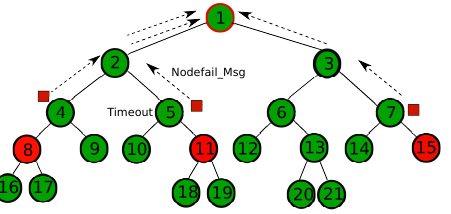
Figure 8. Multiple node failures (in different branches) be waiting for the data from node 11 during the next data collection time slot. When the data collection timeout occurs consecutively for a particular number of time slots (two in our implementation), node 5 will detect the failure of node 11 and will inform the sink node as shown in the figure by sending a NodefailMsg along the tree The data collection timeout is selected su ffi ciently large (few minutes) such that consecutive data collection timeout implies the failure of a Figure 7. Single node failure